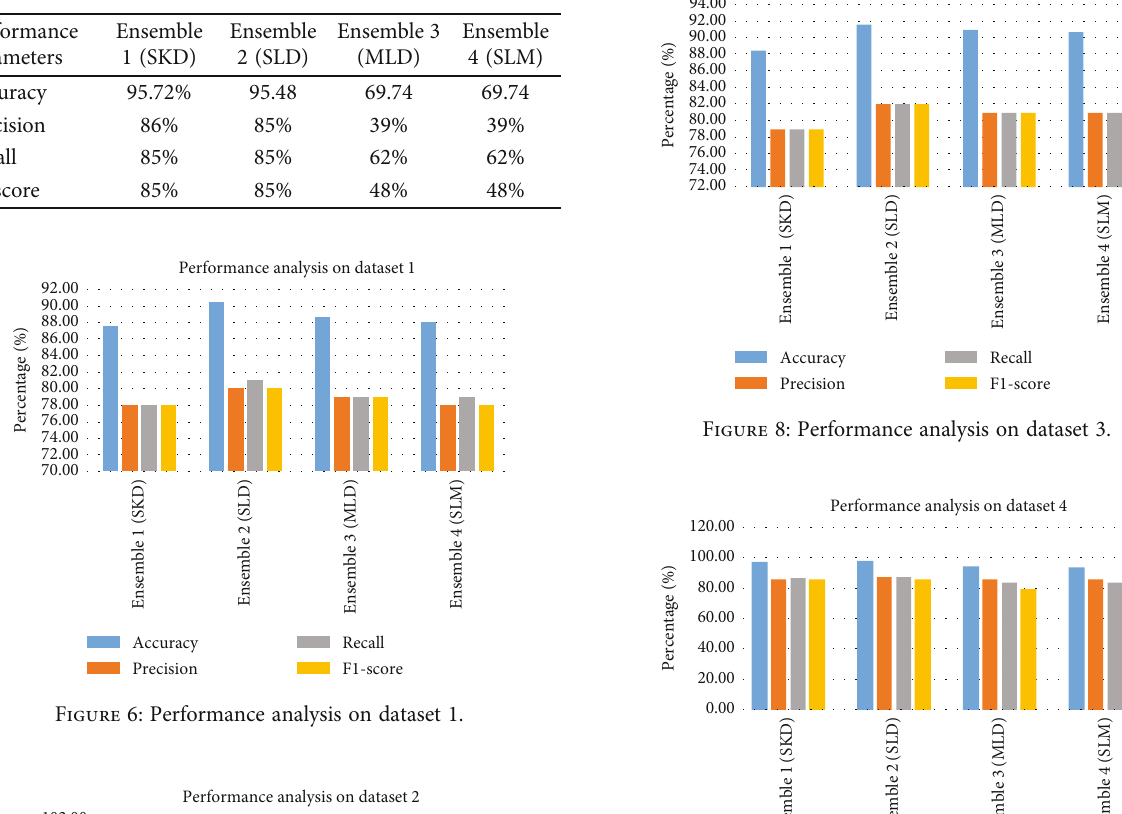
Table 5: Performance of ensemble classi fi ers on dataset 5.